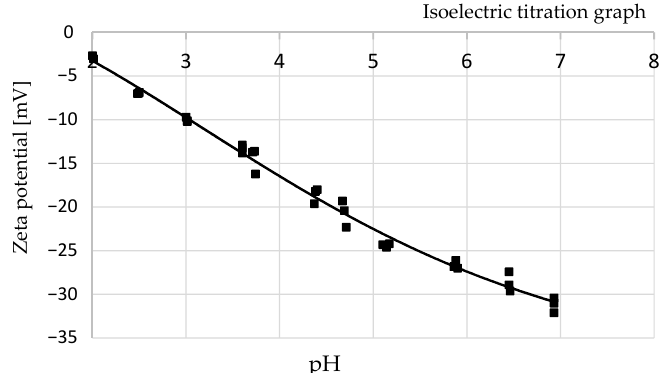
Figure 8. The change in zeta potential with equilibrium pH.